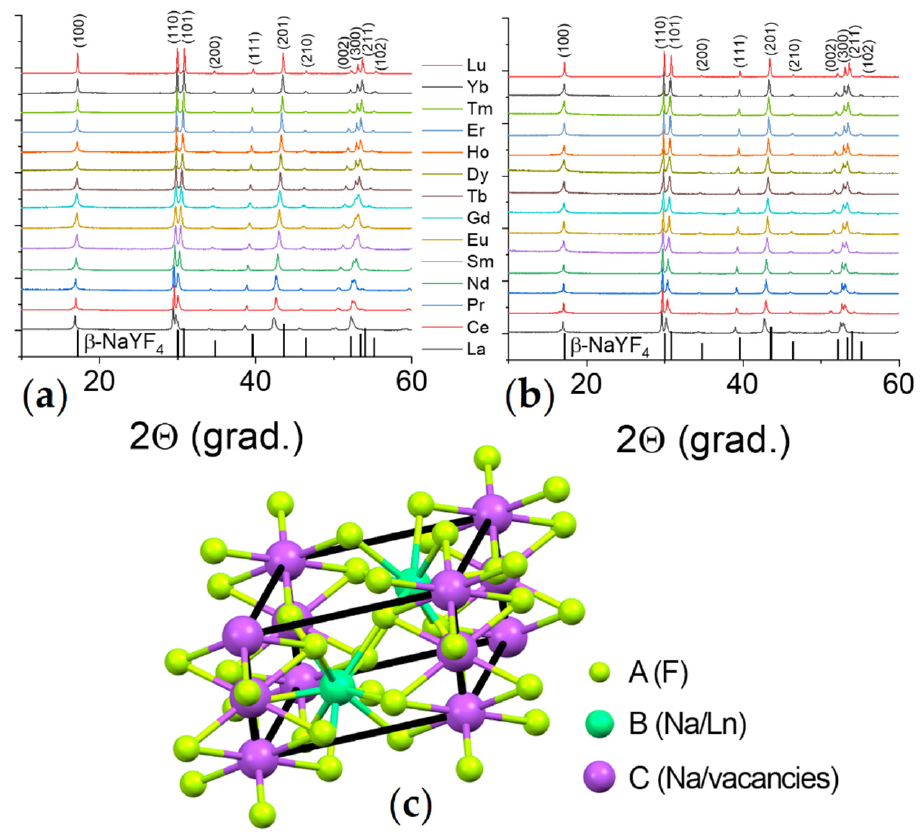
Figure 1. XRD patterns of ( a ) NaY 0.8 Ln 0.2 F 4 and ( b ) NaY 0.6 Ln 0.4 F 4 (Ln = La–Lu); ( c ) the fragment of NaYF 4 crystal structure.